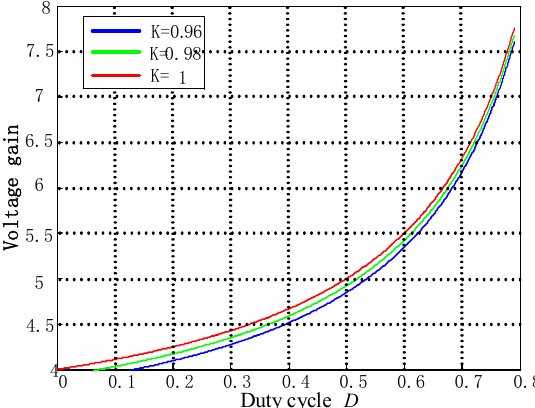
Figure 4. Effect of K on the voltage gain when N = 2.